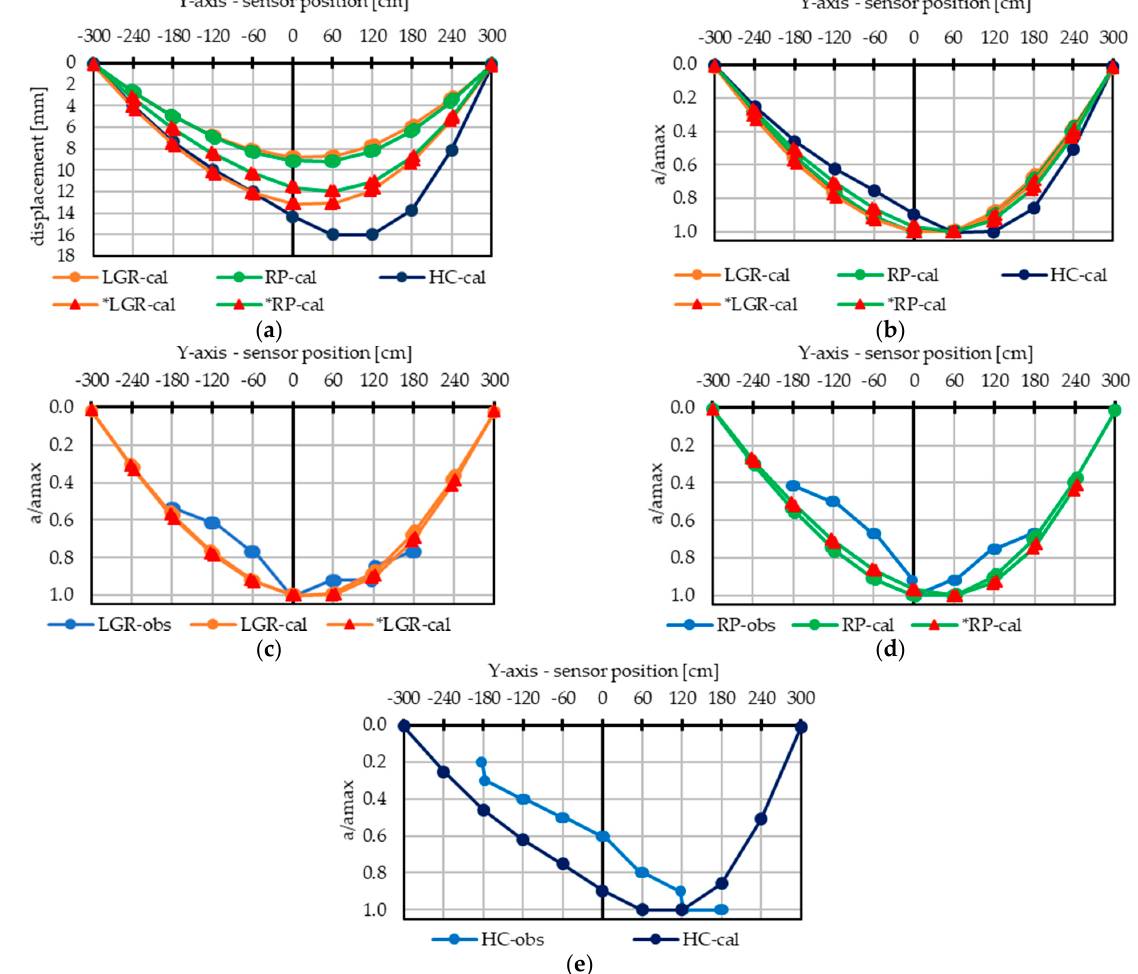
Figure 24. Comparisons of the displacement on the Y-axis between FEM calculation and long-term measurements: ( a ) calculated displacement; ( b ) calculated performance of panels at Y-axis; ( c ) LGR performance; ( d ) RP performance; ( e ) HC panels performance.